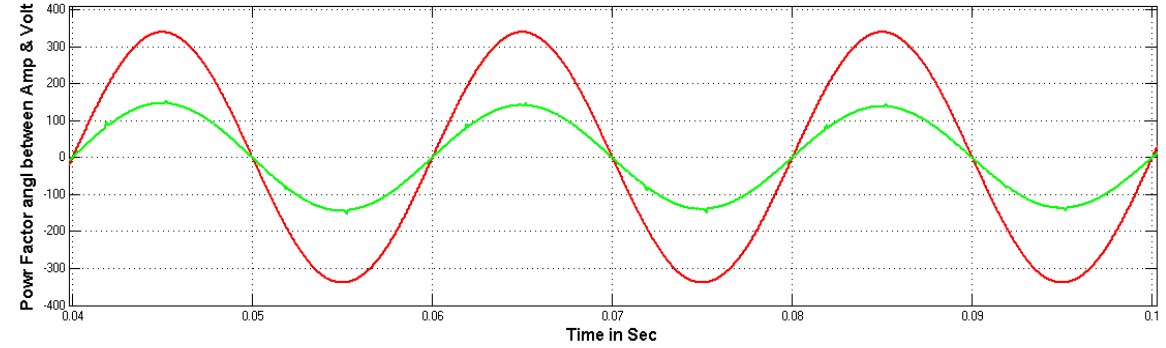
Figure 20. Source current and voltage phase